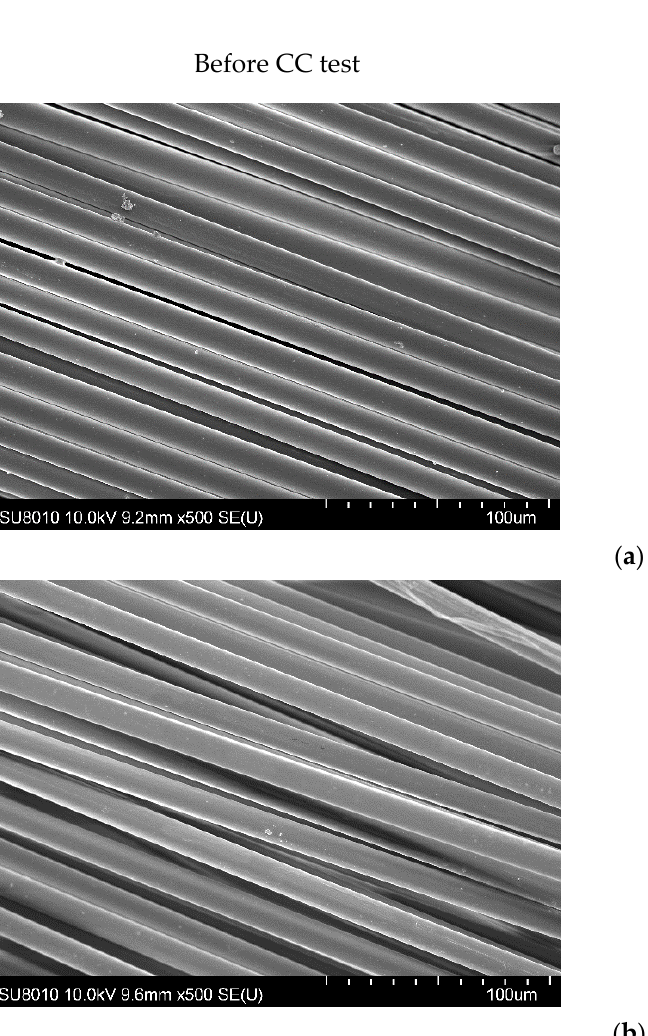
Figure 8. Photographs of GCABF ( a ), CGABF ( b ), CAGBF ( c ), MAGCBF ( d ), VGACBF ( e ), MGACBSF ( f ) after cone calo- rimetry tests.